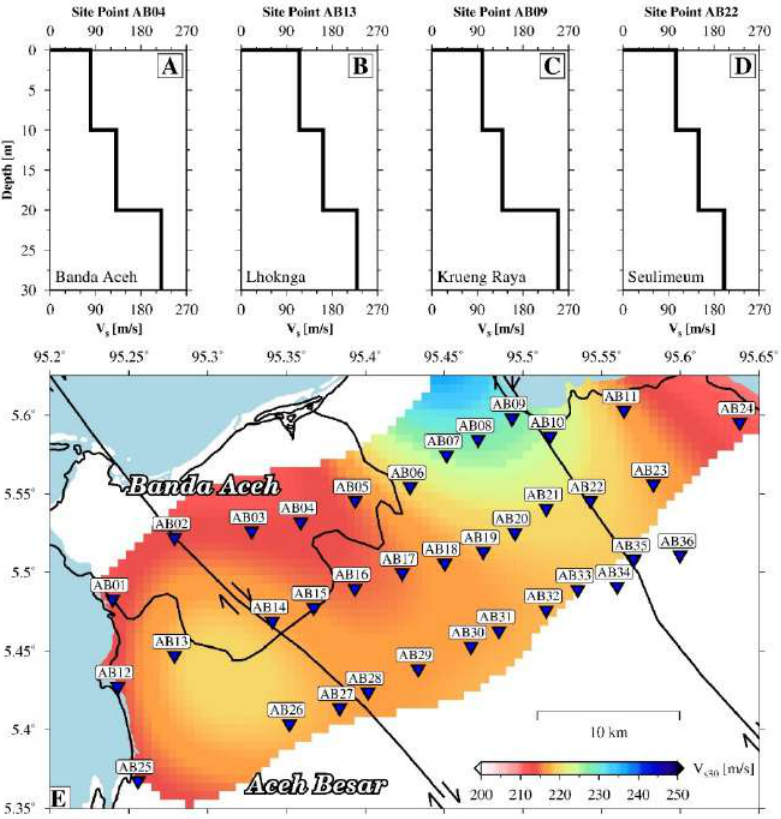
Fig. 5: (a) Examples of 1D velocity model derived from microtremor data obtained by SPAC beneath four sites AB04, AB13, AB09, and AB22; and (b) horizontal profile view of Vs30 as a result of the interpolation of Vs values at all locations